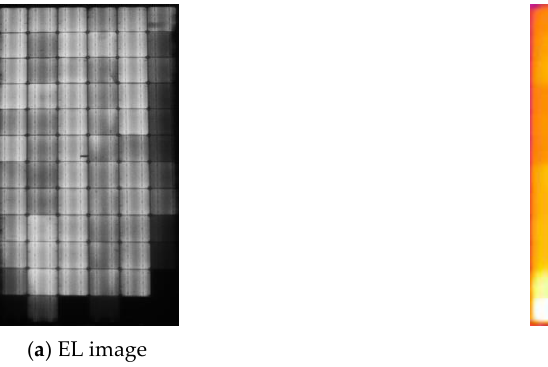
Figure 11. The electroluminescence image ( a ) and thermography image ( b ) of module 14 from the module string 7 corresponding to Figure 5a. The EL image and IR image of PID-affected monocrystalline silicon solar module exhibit an irregular change.